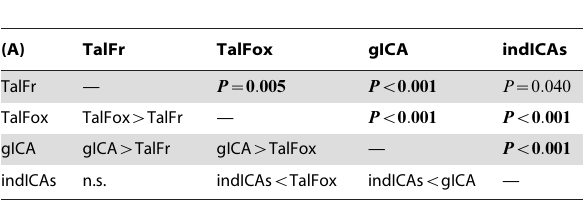
Upper triangular matrix: significance level of an effect of method. Significant P -values at a threshold of p ~ 0 : 05 corrected are emphasized in bold. Lower triangular matrix: direction of effect.